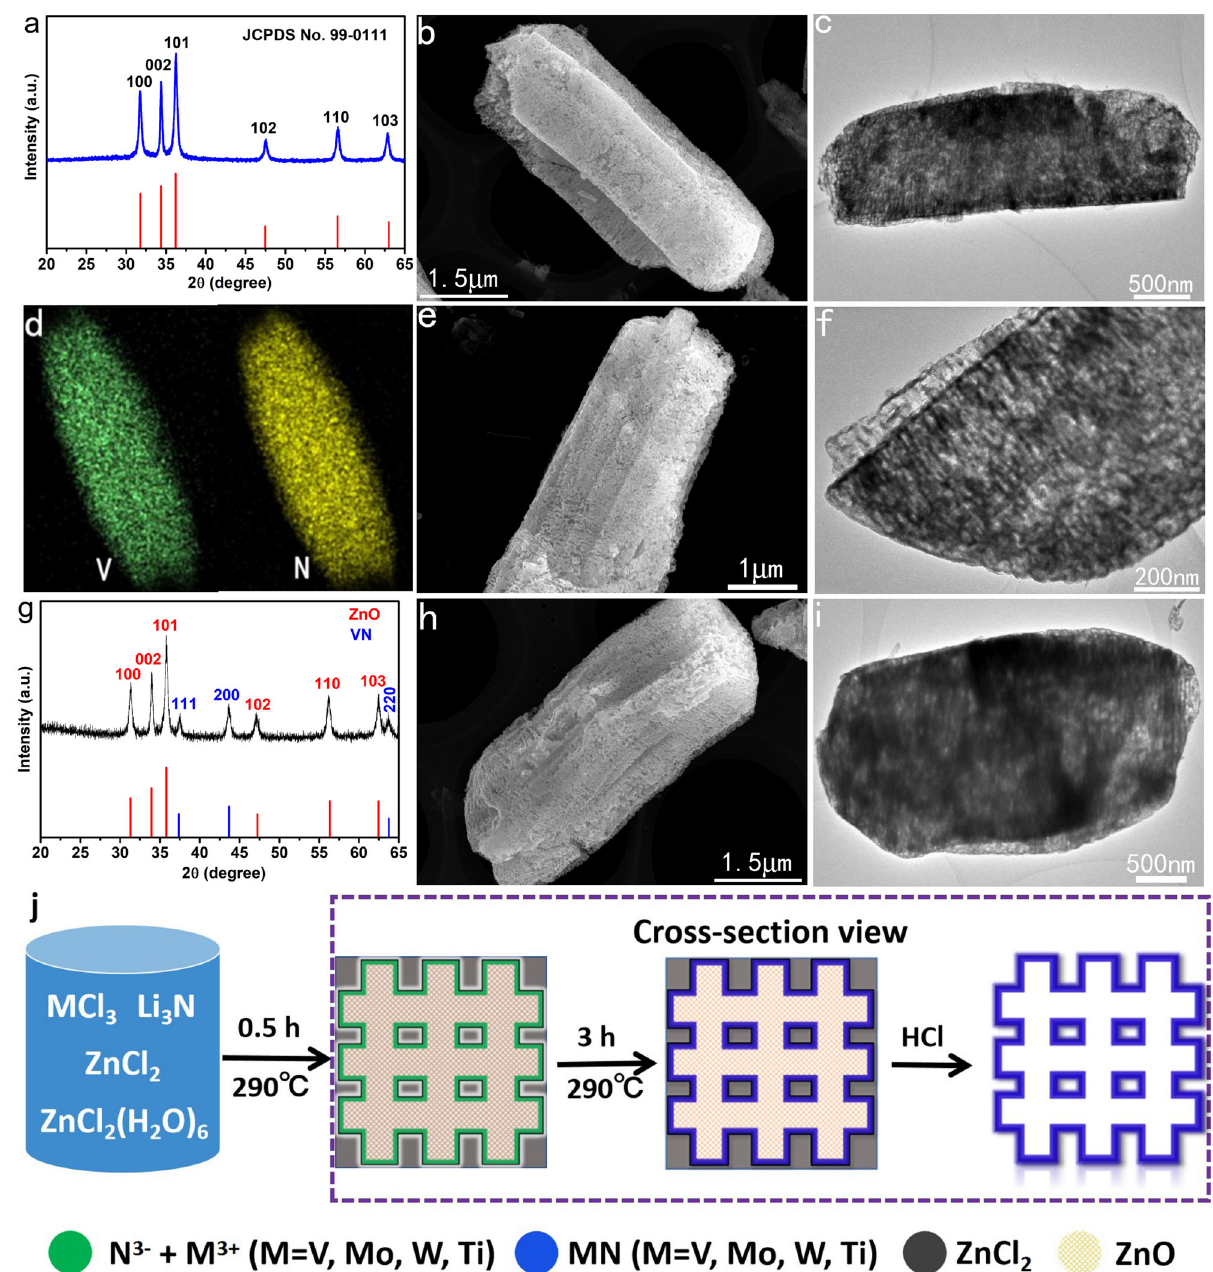
Fig. 3 Formation mechanism of the 3D porous VN. a – d XRD pattern, SEM image, TEM image, and EDS mapping of the products formed after 0.5 h reaction. e – g SEM image, TEM image, and XRD pattern of the products formed after 3 h reaction. h , i SEM and TEM images of the 3D porous ZnO formed in the absence of Li 3 N and VCl 3 . j Formation mechanism scheme of the 3D porous